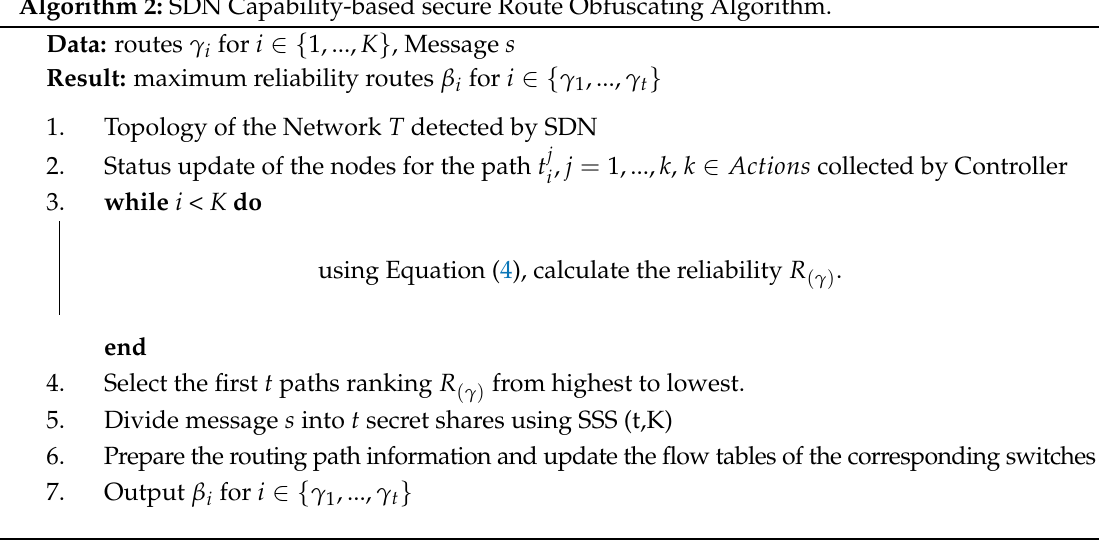
Algorithm 2: SDN Capability-based secure Route Obfuscating